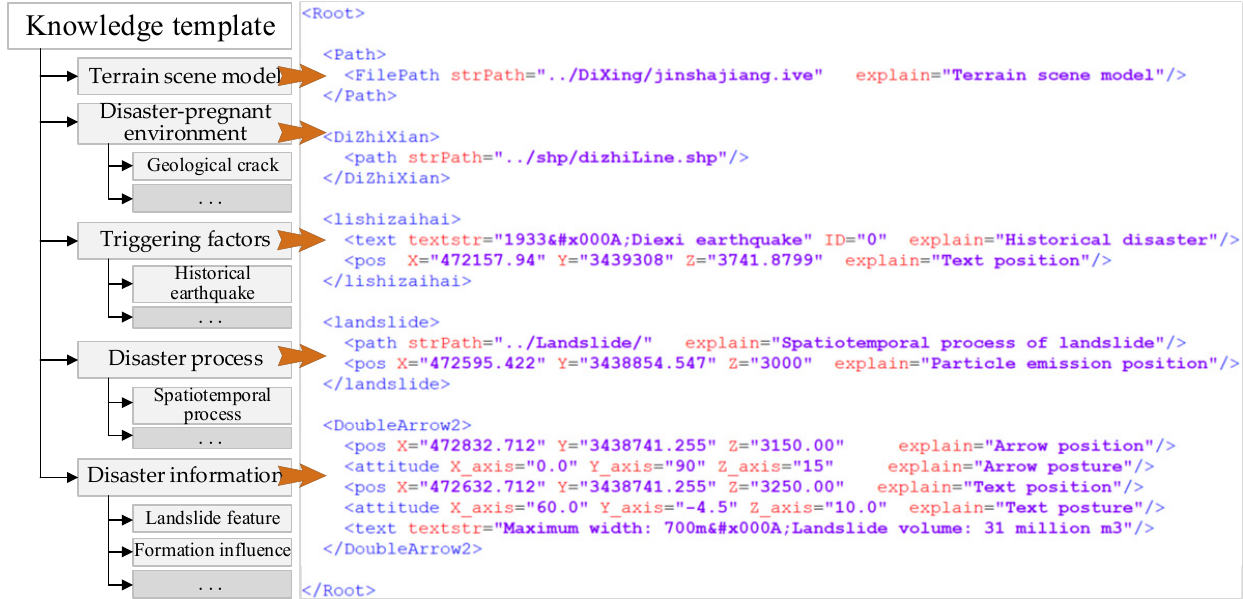
Figure 2. Disaster scene visualization knowledge template structure.